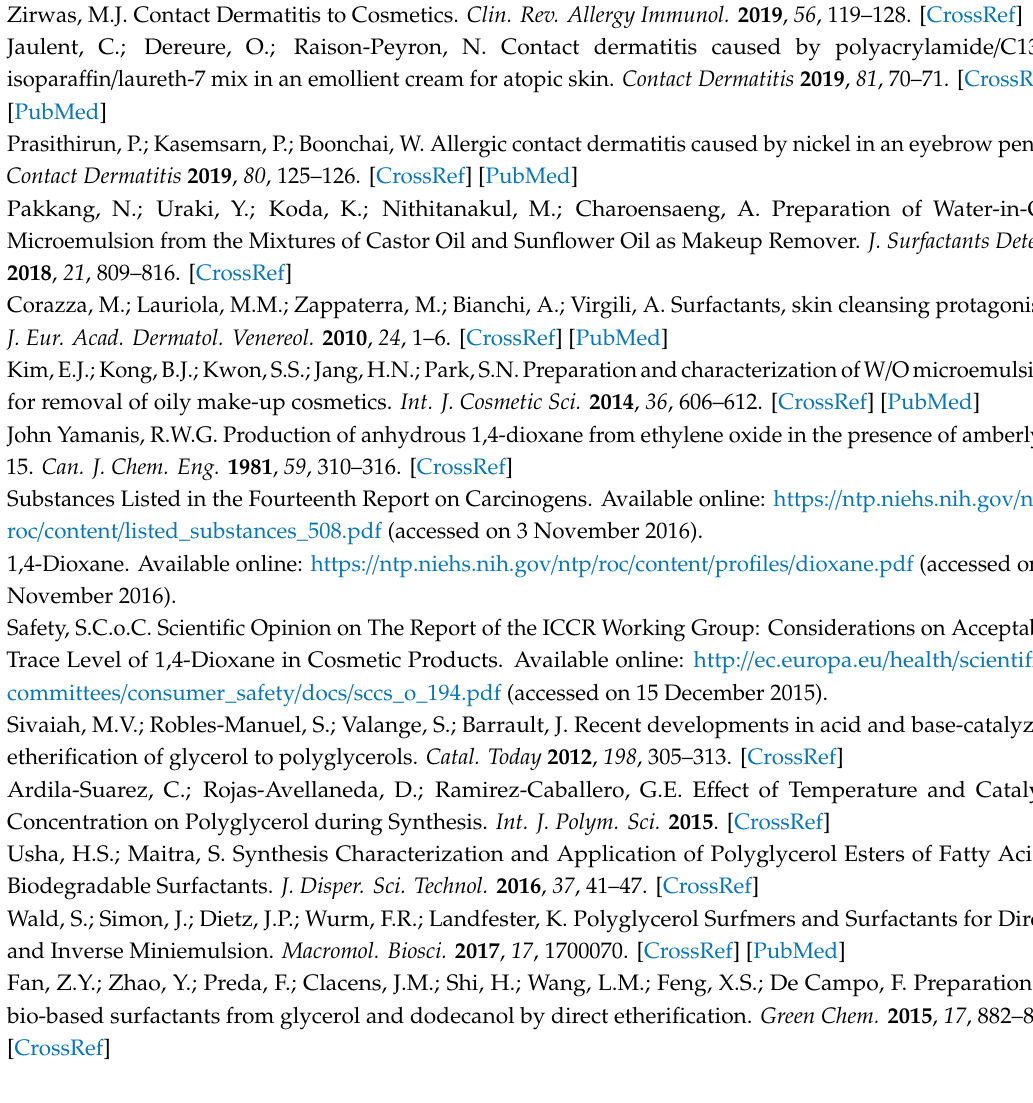
Figure S1: Photos of chicken embryo chorioallantoic membrane in contact with (a) 4 wt% PGCE-1 solution, (b) 4 wt% P6CCG solution, (c) 4 wt% olive oil PEG-8 esters, (d) 4 wt% Poloxamer 184, (e) 0.9 wt% NaCl solution, and (f) 0.1 mol / L NaOH solution for 60